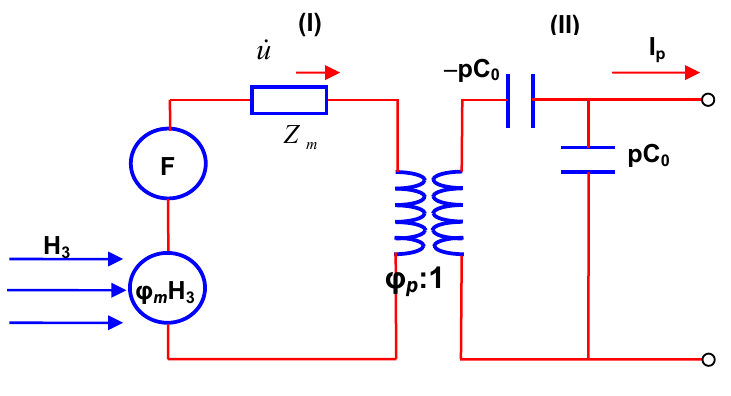
Figure 4. Equivalent circuit model for magnetoelectric energy